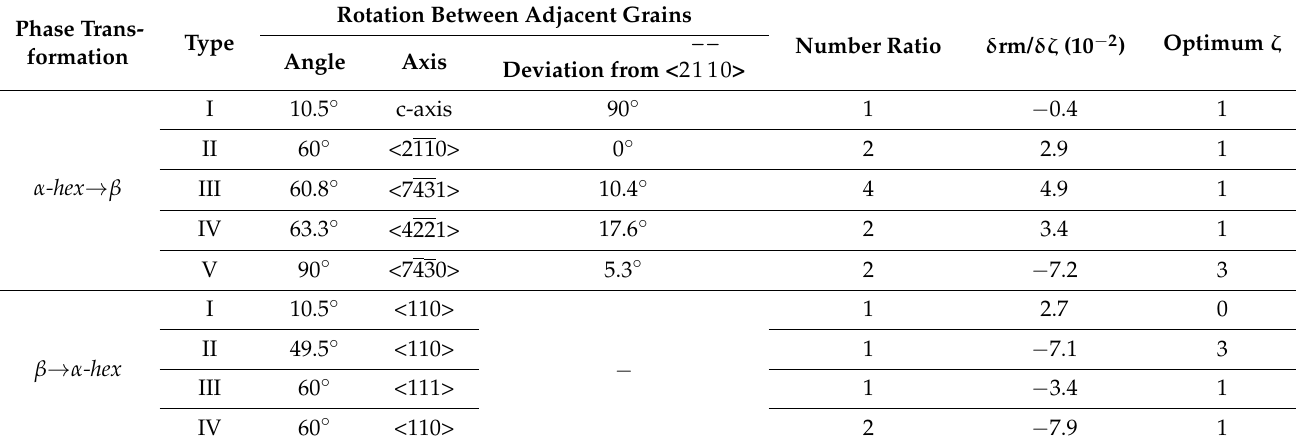
Table 1. Special boundaries for DBOR and δ rm/ δζ and optimum ζ for predictions by EDBOR n = 1 scheme. Phase Trans-